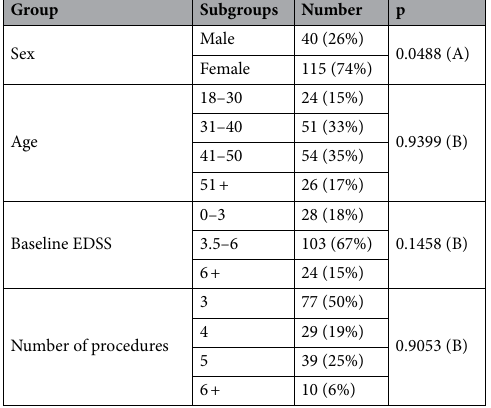
Table 1. Analyzed groups and subgroups. A—Two-sample Wilcoxon rank–sum test, B—Kruskal–Wallis equality of populations rank test.